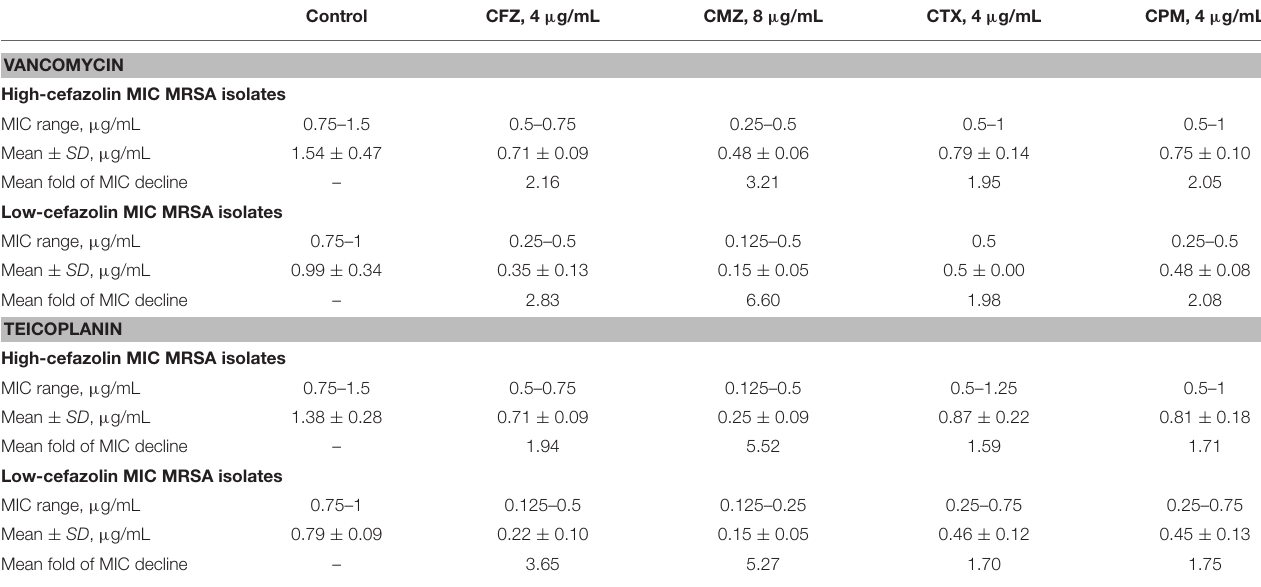
TABLE 5 | The MICs of vancomycin or teicoplanin in the absence and presence of a 1/2 susceptible breakpoint concentration of a cephalosporin for 13 high-cefazolin MIC and 21 low-cefazolin MIC isolates of methicillin-resistant Staphylococcus aureus (MRSA).